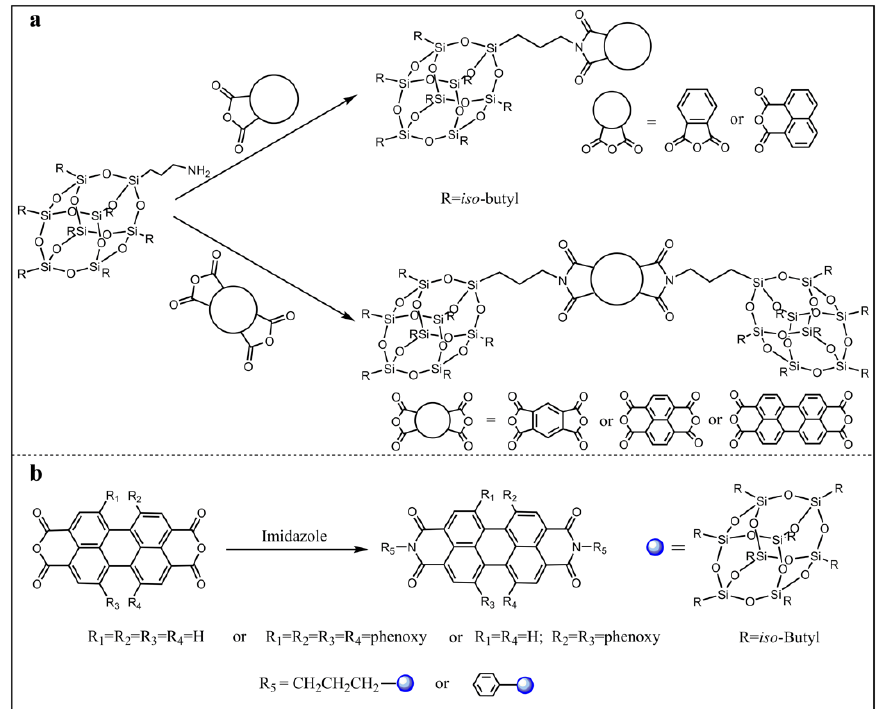
Figure 2. ( a ) Synthetic procedure and molecular structures of a variety of POSS imides [70]. ( b ) Synthetic procedure and molecular structures of a series of dumbbell POSS-PDI [71].